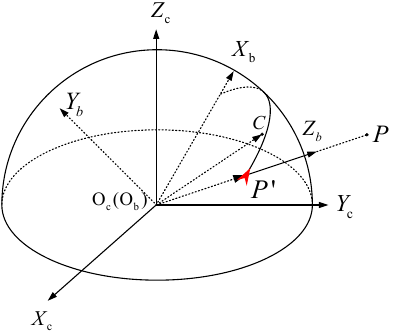
Figure 3. Feature point attitude coordinate